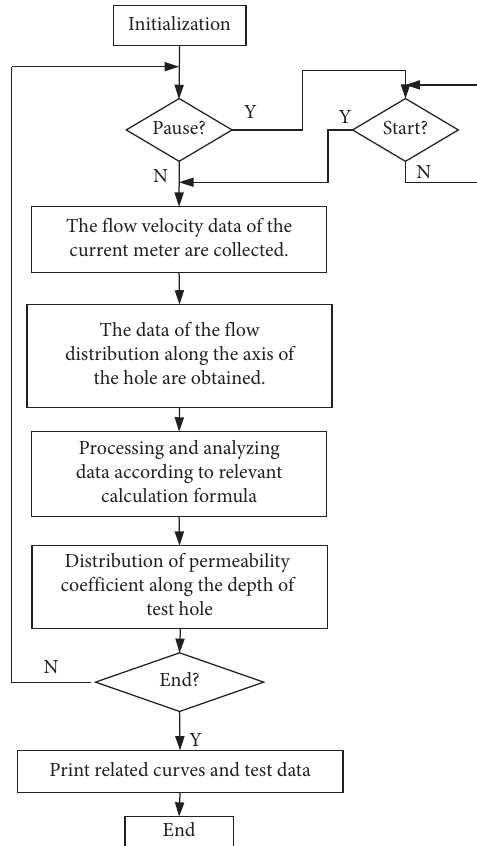
Figure 4: Main program flowchart.